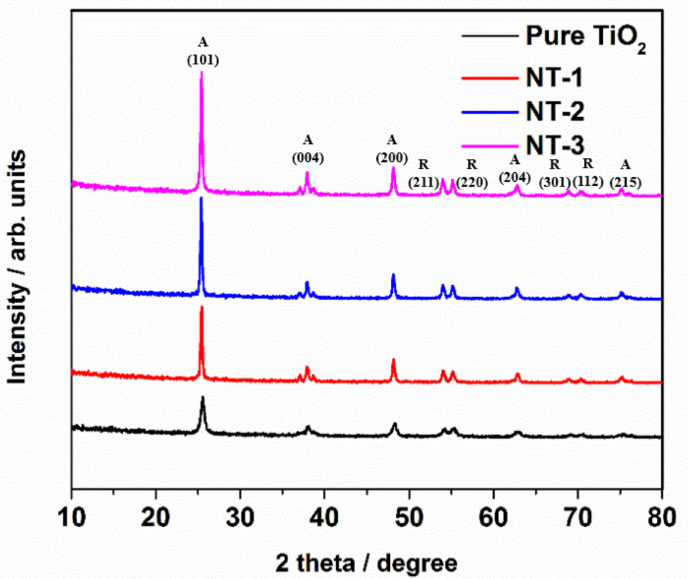
Figure 1. XRD patterns of pure TiO 2 , NT-1, NT-2 and NT-3, synthesized by using 0.0 g, 0.983 g, 1.965 g and 2.940 g of urea respectively (A: anatase phase, and R: rutile phase).